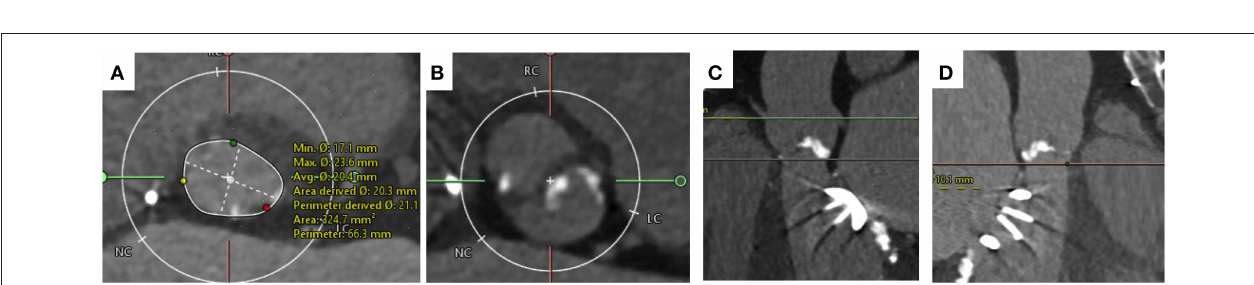
Frontiers in Cardiovascular Medicine |